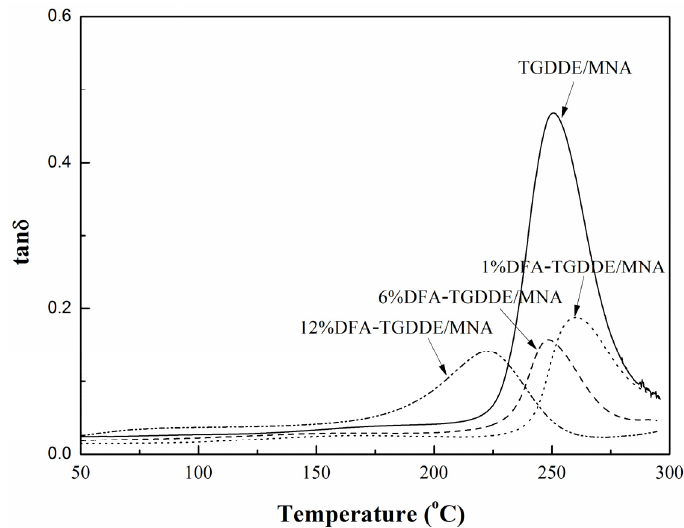
Figure 9. Loss modulus curves of the cured resins, 5 °C/min, 1 Hz.